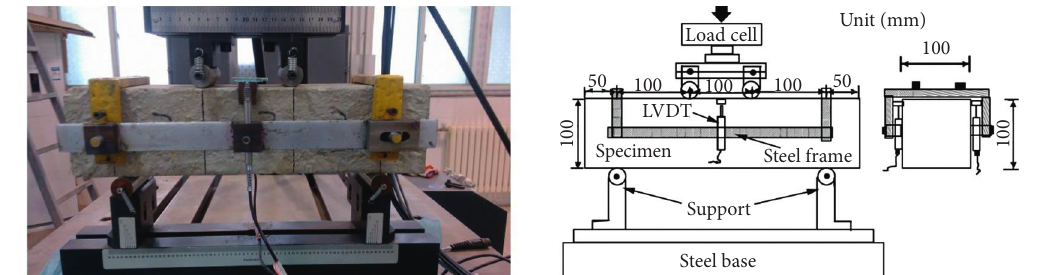
Figure 3: Test setup of flexural strength. Table 5: Test results of mechanics strength (MPa).